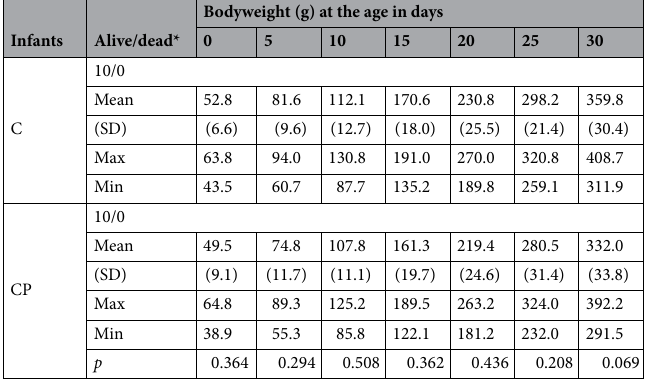
Table 2. Bodyweight records of the two groups of rabbits every 5 days. Mean values, standard deviation (SD), the Max values, the Min values, and p values at each time point are shown for each group (C: control group; CP: cleft palate group). *Number of deaths within 1 month of age.